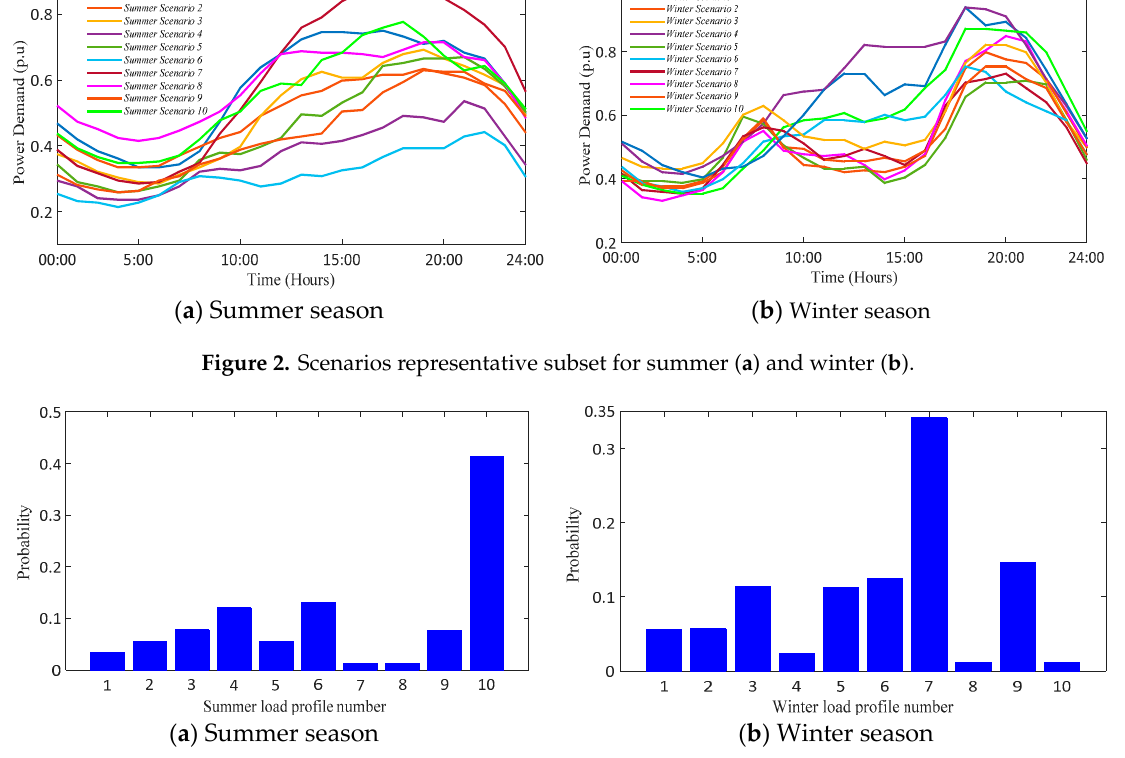
Figure 3. Probability of occurrence of summer ( a ) and winter ( b ) reduced profiles.